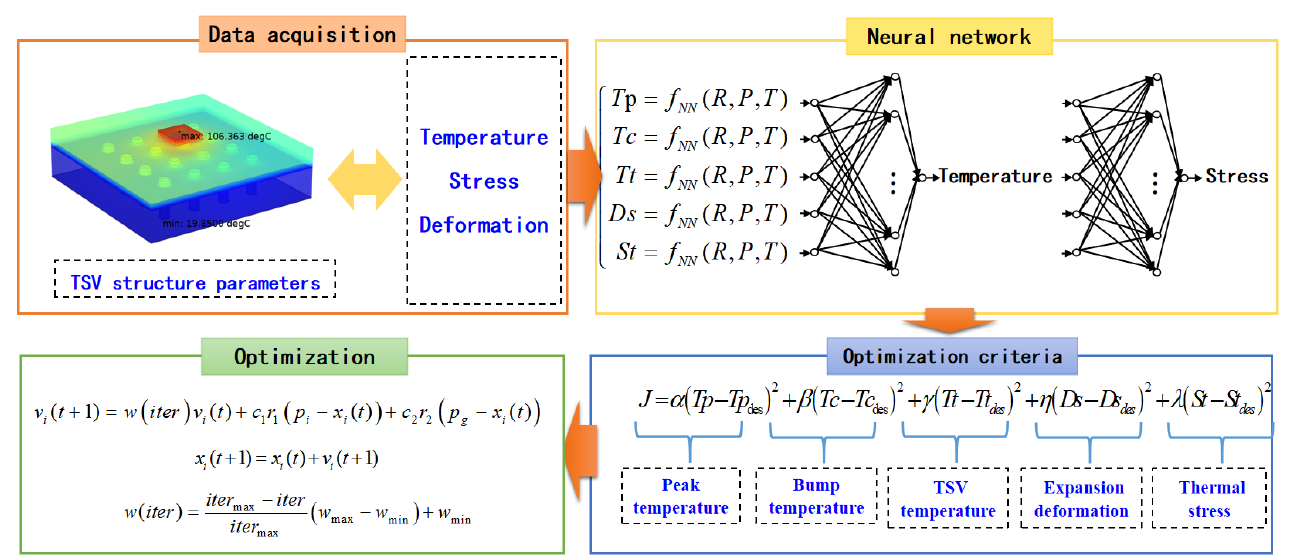
Figure 1. Flowchart of the developed intelligent optimization method for the parameters of TSV.